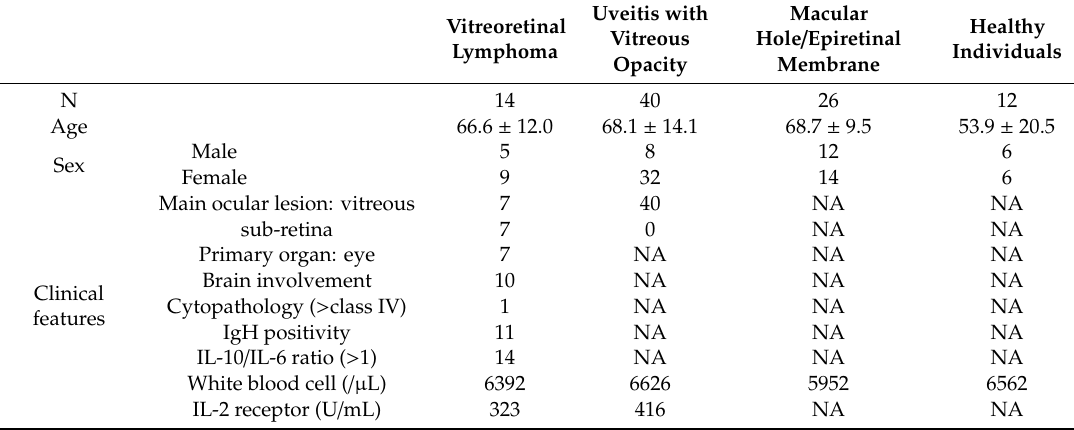
Table 1. Demographic, clinical and laboratory data of vitreoretinal lymphoma (VRL) patients and controls.